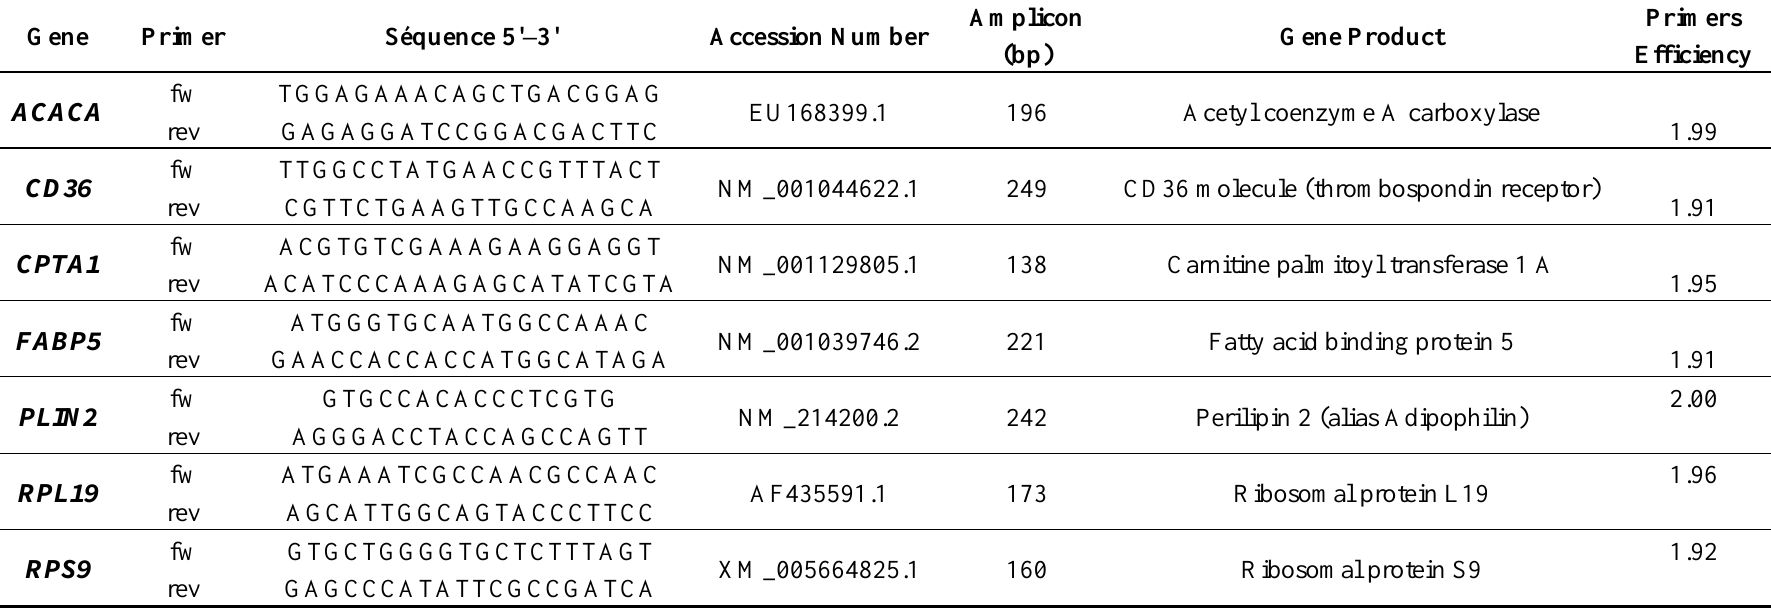
Table 1. Primers used for real-time PCR gene expression